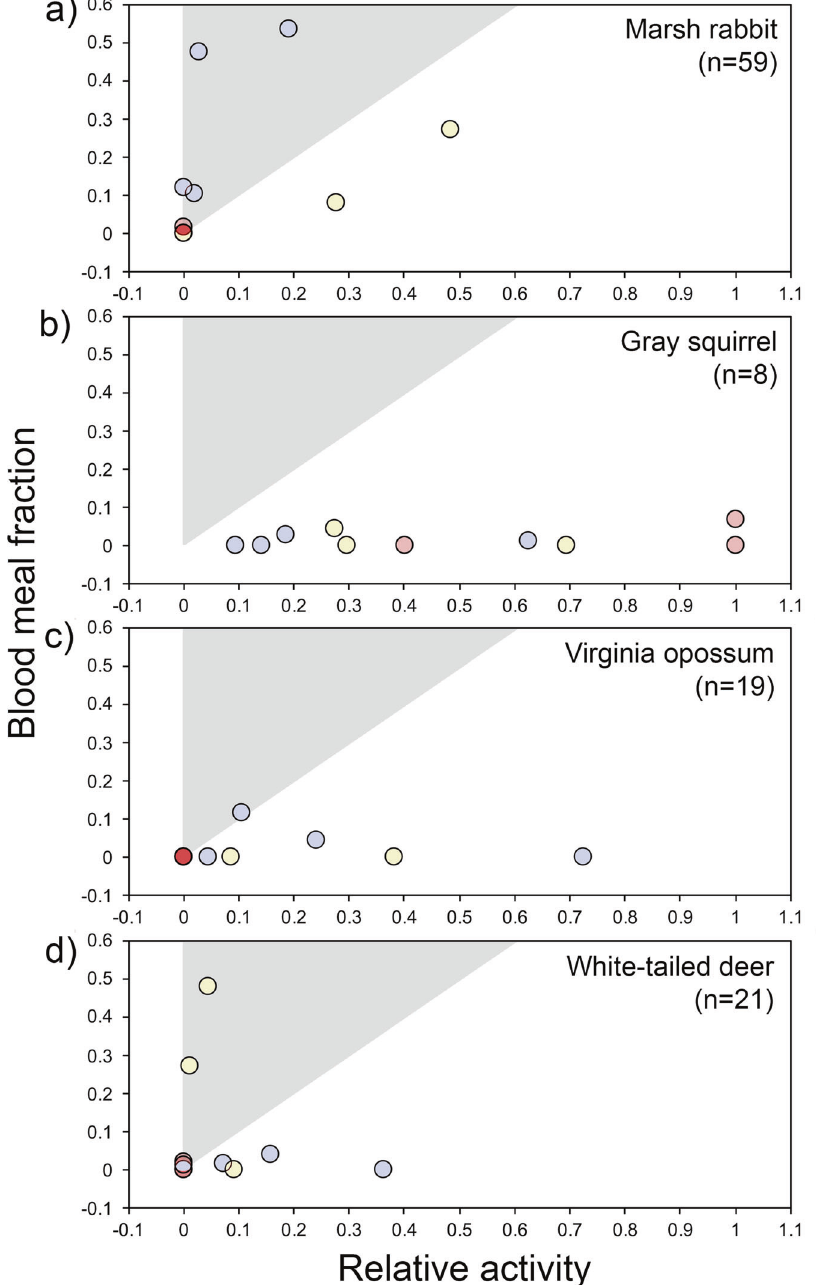
Fig. 4 Relative activity and blood meal fraction of mammals across sites with varying relative probabilities of python presence. Total numbers of blood meals from marsh rabbit ( a ), gray squirrel ( b ), Virginia opossum ( c ), and white-tailed deer ( d ) are provided in each panel. Colors of points represent high (red), moderate (yellow), or low (blue) estimated python presence, based upon species distribution model output. Gray triangular shading of the plot area indicates host preference (ratio of host use to relative abundance) by Culex cedecei . The relative activity of mammals was quanti fi ed through strati fi ed camera trapping. The blood meal fraction was quanti fi ed using PCR-based assays to identify the vertebrate source of DNA in blood-engorged female